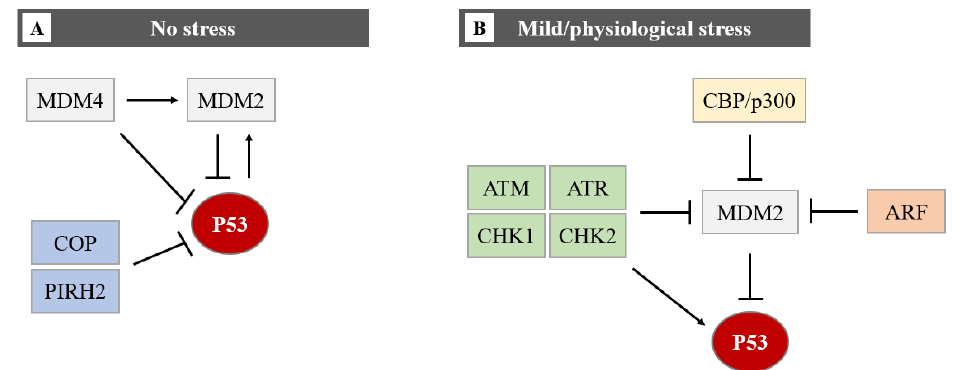
Figure 4. The regulation of the P53 protein level in cells in no stress and mild/physiological stress. During no stress ( A ), E3-ubiquitin ligases (MDM2, COP, and PIRH2) inhibit P53 activity through polyubiquitination and proteasome degradation. The function of P53 and MDM2 is regulated by a negative feedback loop. MDM4 can bind directly to P53 by repressing P53 transcriptional activity, or it can promote MDM2-mediated degradation of P53. The MDM2-P53 association promotes the degradation of P53 because physiological degradation of P53 is ubiquitin-dependent and MDM2 acts as a P53-specific E3 ubiquitin ligase. In conclusion, as MDM2 expression is positively regulated by P53, MDM2 drives P53 proteasomal degradation, it becomes apparent that MDM2 and P53 form an autoregulatory loop. In this loop, MDM2 restrains P53 levels under normal physiological conditions. Under mild/physiological stress states ( B ), MDM2 levels are kept low by ATM, ATR, CHK1 and CHK2, ARF, and CBP/p300. The low level of MDM2 induces the expression of P53. In the presence of mild/physiological stress, the level of these proteins increases.